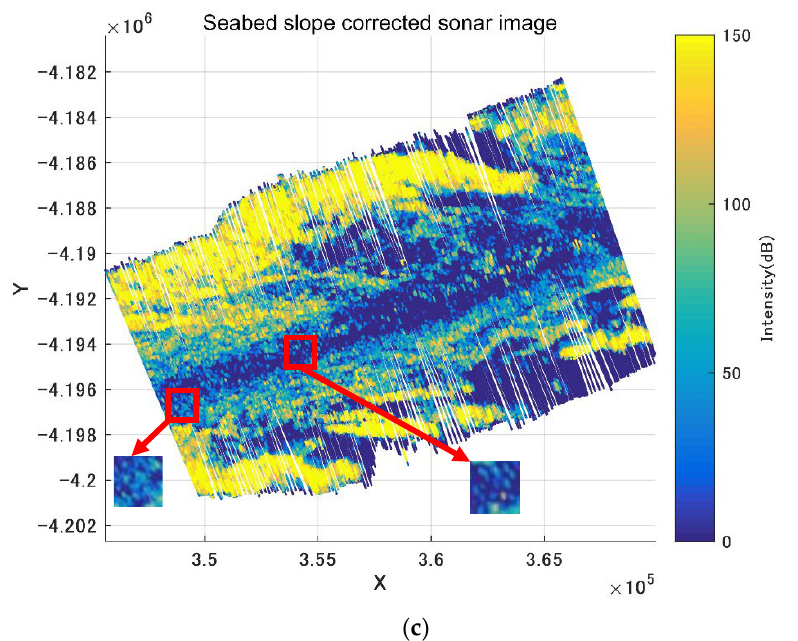
Figure 6. Influence of seabed topography fluctuation on backscatter intensity and corrected intensity image in the Longqi hydrothermal area: ( a ) sound intensity contrast chart after TVG correction and terrain slope correction; ( b ) original sonar image without terrain slope correction; and ( c ) seabed sonar image after terrain slope correction.